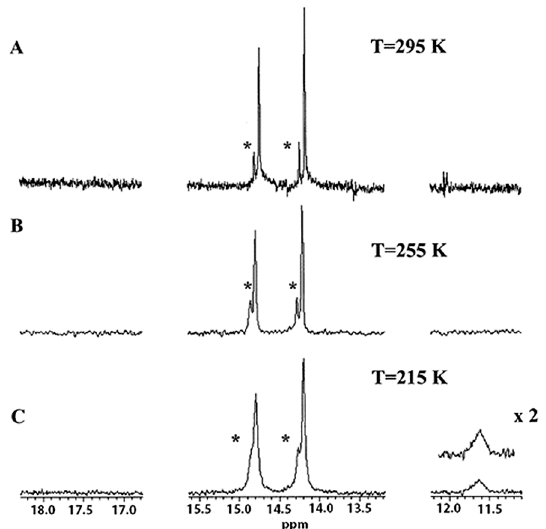
Figure 18. Variable temperature gradient 1 H NMR spectra of hypericin in acetone-d 6 (neutral form ( 1 ), Figure 17), number of scans 128, 754 and 1952 for A, B and C, respectively. The asterisk denotes an unknown compound. Adopted, with permission, from [101]. Copyright 2002, by Elsevier Science Ltd.